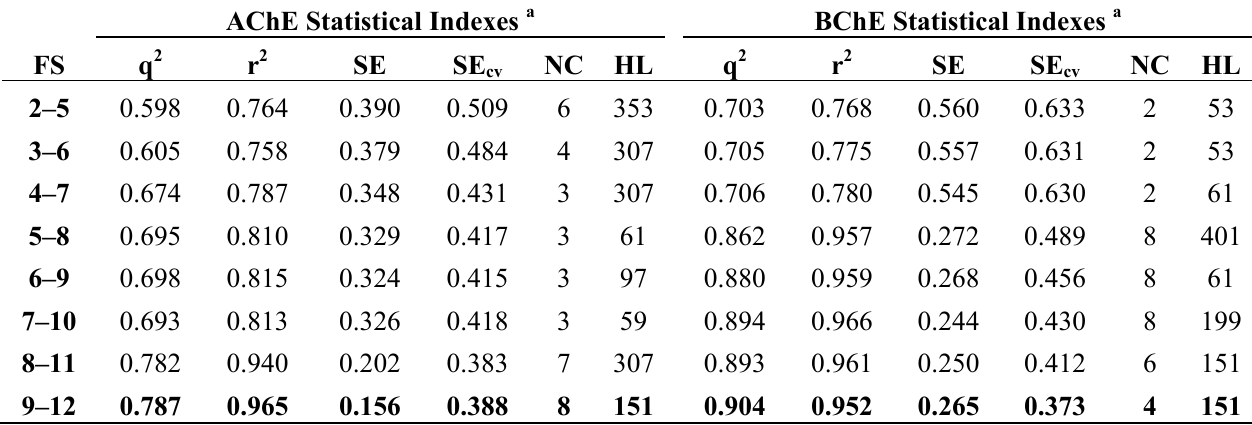
Table 3. Summary of HQSAR statistical indexes for the influence of various fragment sizes (FS) using the fragment distinction parameters B/C and A/B for AChE and BChE inhibitors,